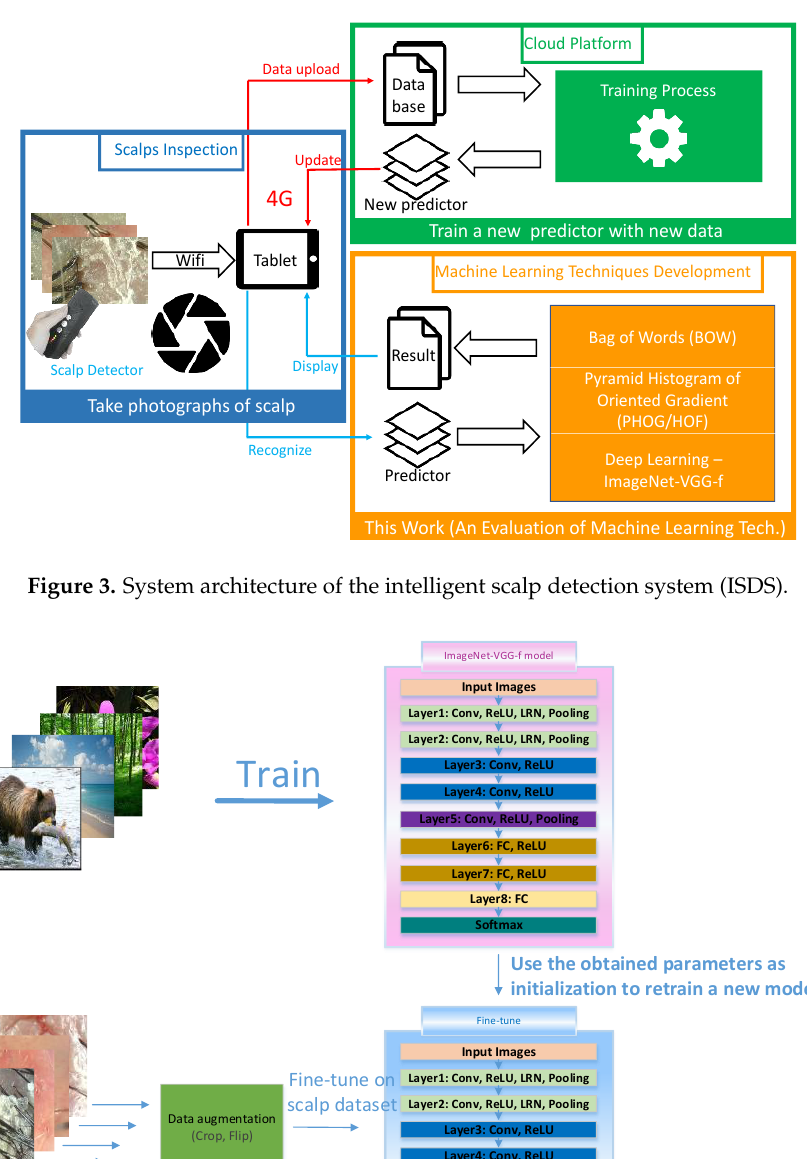
Figure 4. Training and testing of the deep-learning structure.